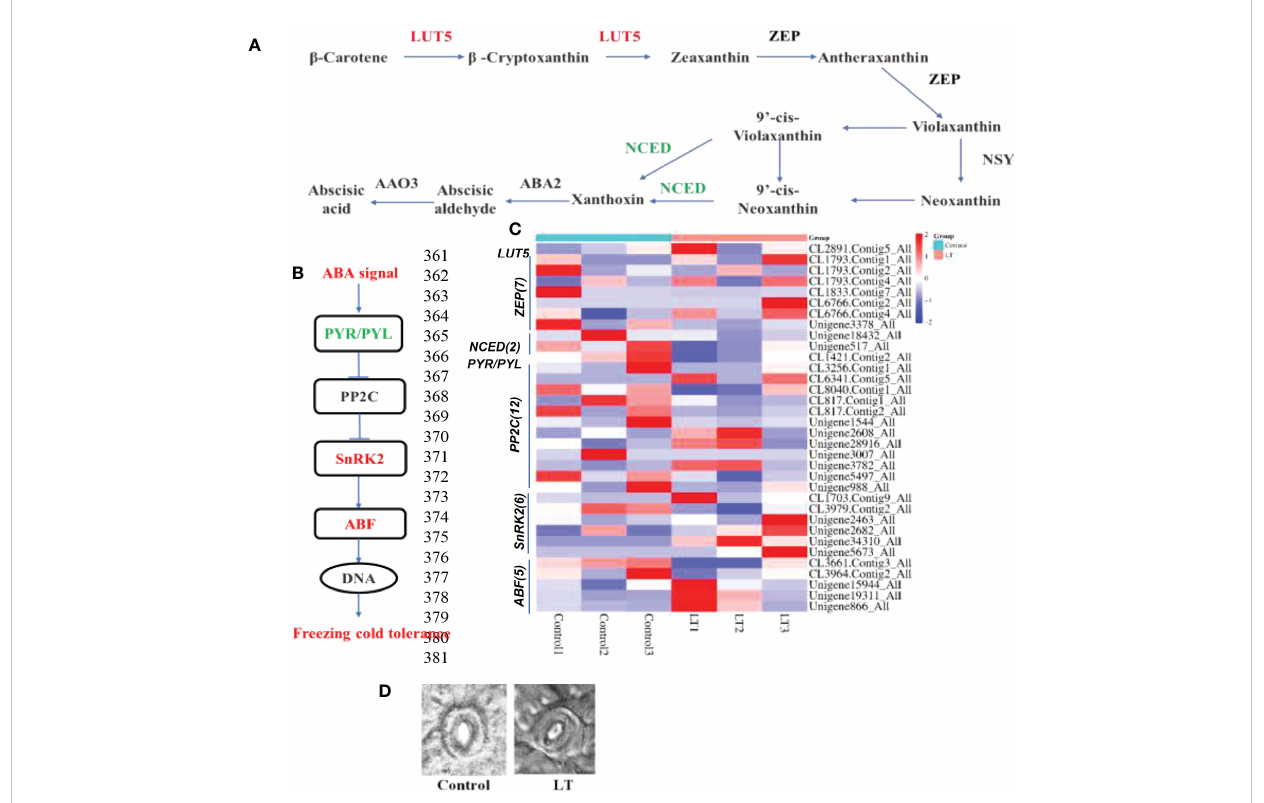
FIGURE 4 The response of ABA biosynthesis and signaling pathway to cold stress. (A) The KEGG was used to build the ABA biosynthetic pathway. (B) The pathway of ABA signaling transduction. (C) Heat map clustering analysis of ABA biosynthesis and ABA signaling genes after cold stress according to their expression levels. (D) In the control and LT groups, the abaxial epidermal stomatal morphology of R. chrysanthum